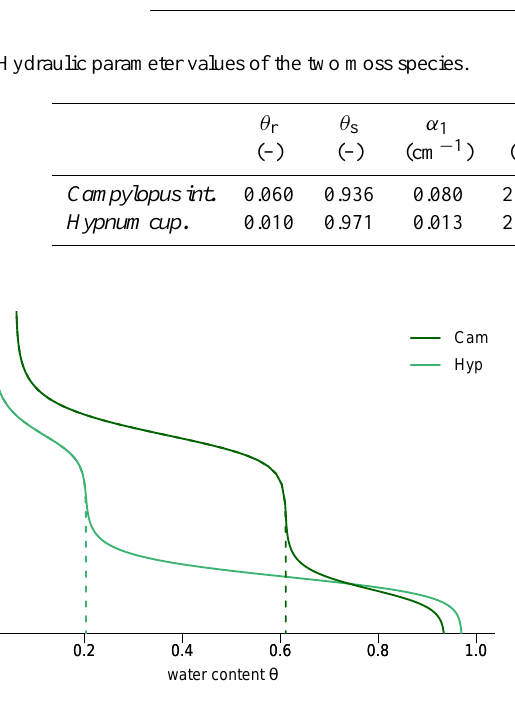
Figure A1. Water retention functions of two moss species: Campy- lopus introflexus and Hypnum cupressiforme . The dotted lines indi- cate the contribution of the capillary pore system, characterized by Voortman et al. (2014).